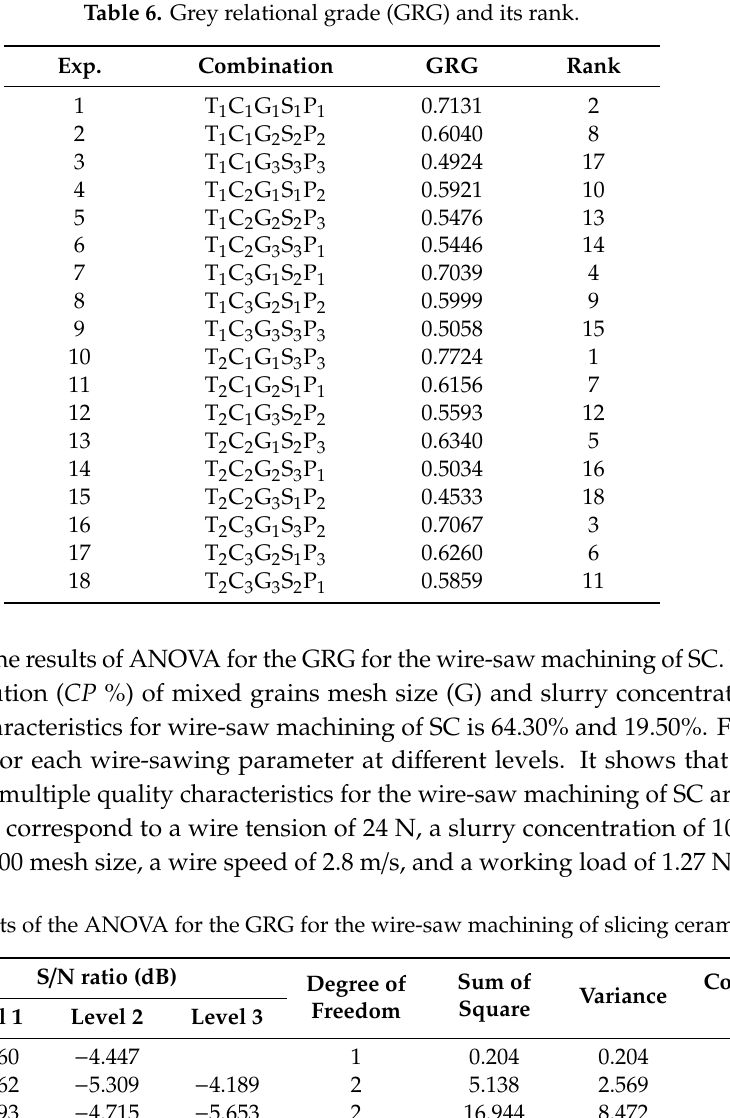
Sum of Variance Square Freedom